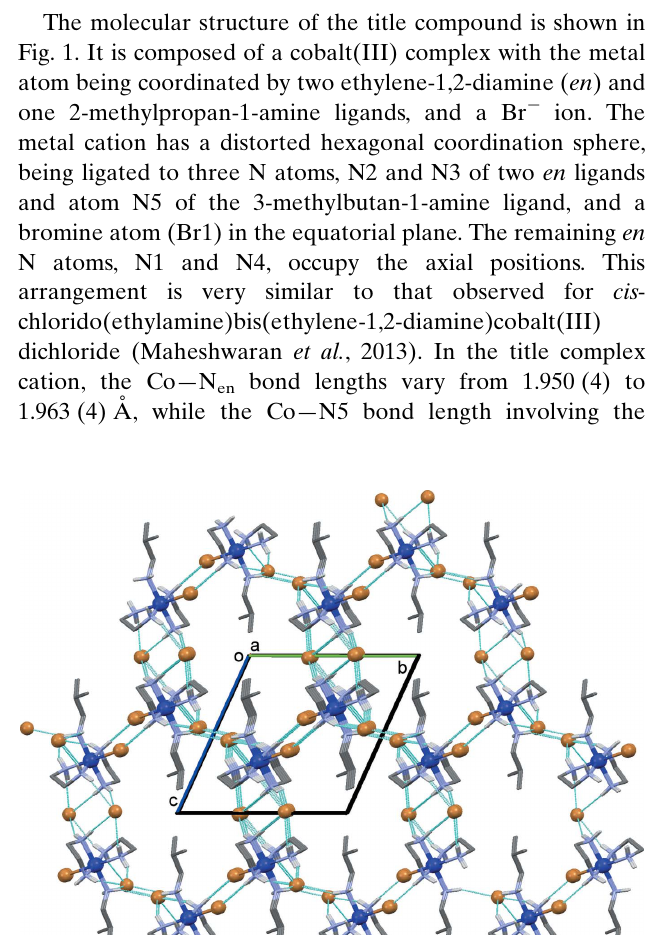
Figure 1 The molecular structure of the title complex, with the atom labelling. Displacement ellipsoids are drawn at the 50% probability